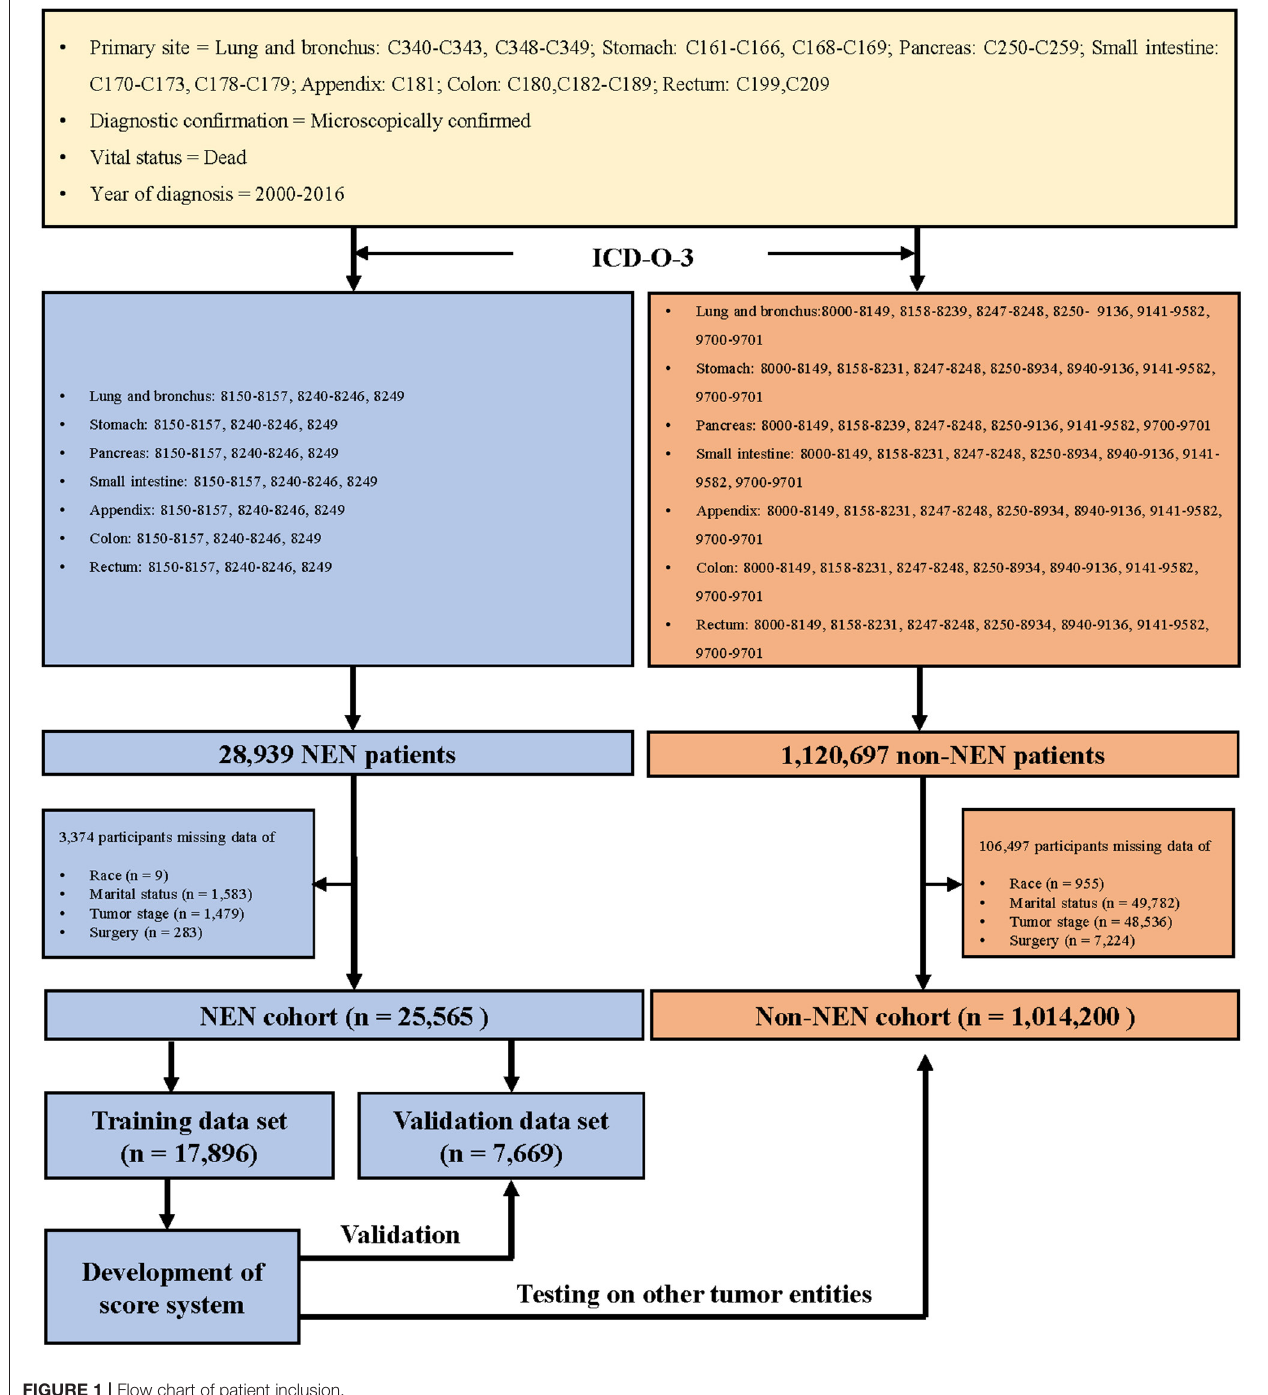
FIGURE 1 | Flow chart of patient